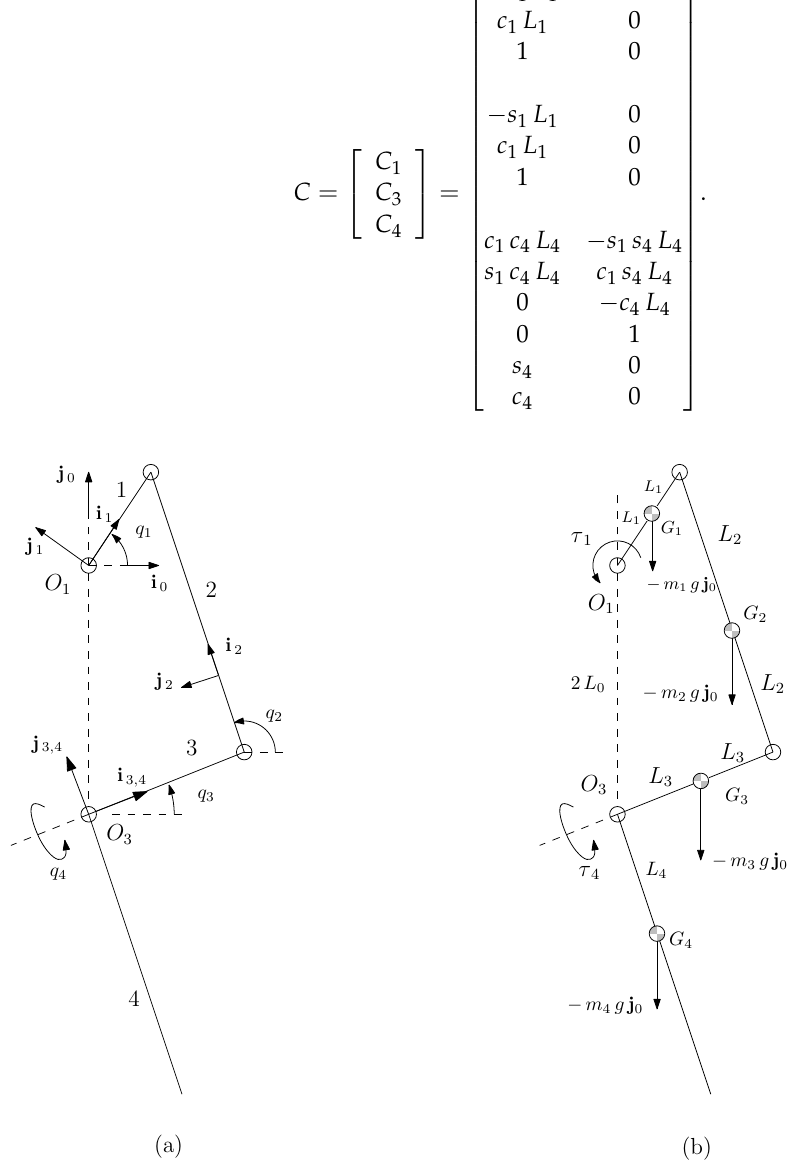
Figure 5. Model conventions: ( a ) frames and variables; ( b ) centres of mass, gravitational forces and